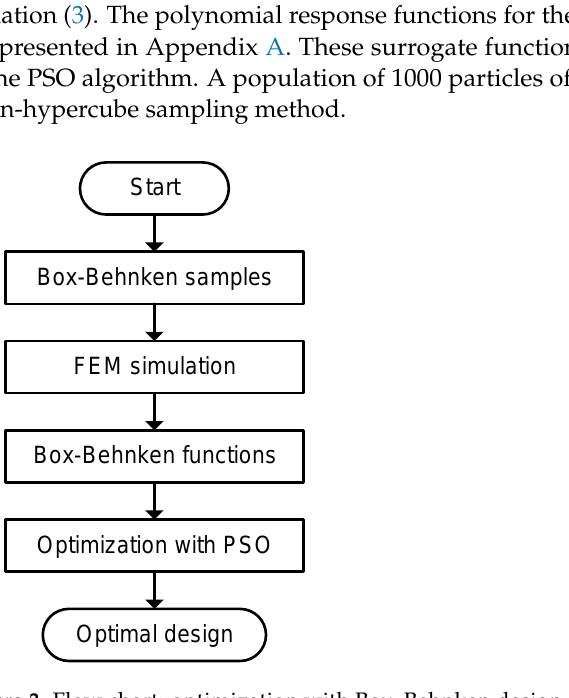
Figure 3. Flow chart: optimization with Box–Behnken